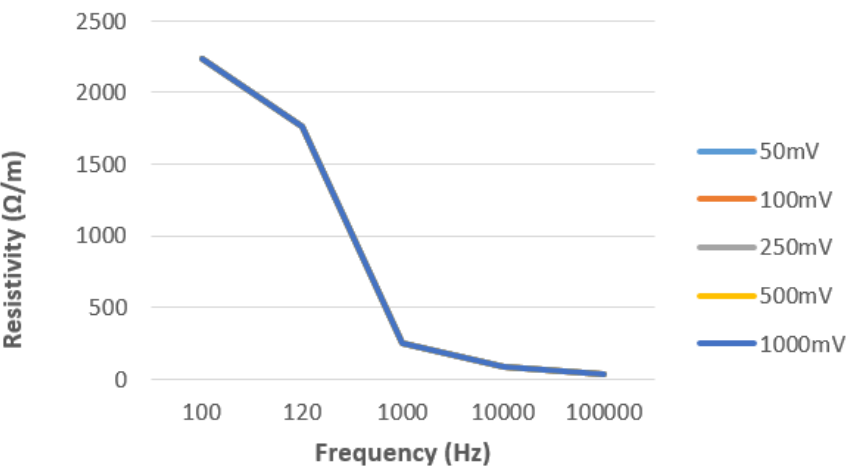
Figure 8. The resistivity of ZnSe-Fe crystal as a function of frequency at di ff erent bias voltages. Resistivity did not change with bias voltage.